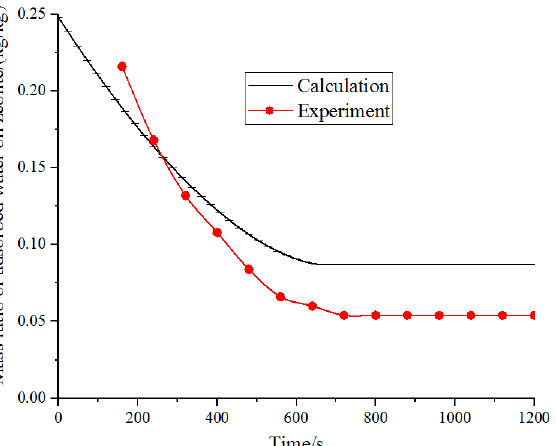
Figure 7. Comparison between experiment and calculation of transient physisorption capacity of zeolite during the desorption process.